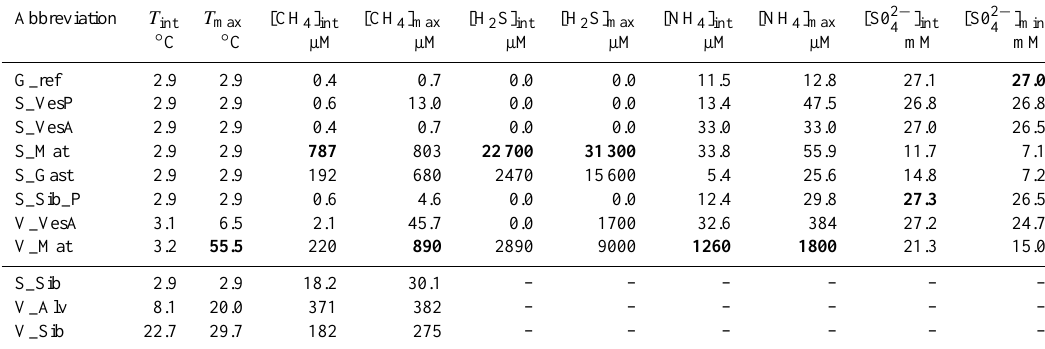
Table 2. Temperature and methane concentrations measured for all assemblages (pore-water measurements within soft sediment and water measurements above hard substratum) and hydrogen sulfide, ammonium and sulfate pore-water concentrations within soft sediment assem- blages. Physico-chemical factors are summarised as substratum–water interface values and maximum values measured among assemblages. Highest values are highlighted in bold.